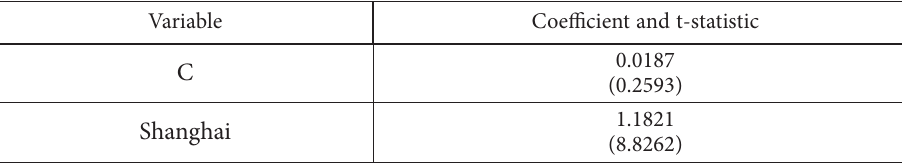
Table 1. Correlation between Shanghai and Shenzhen stock markets